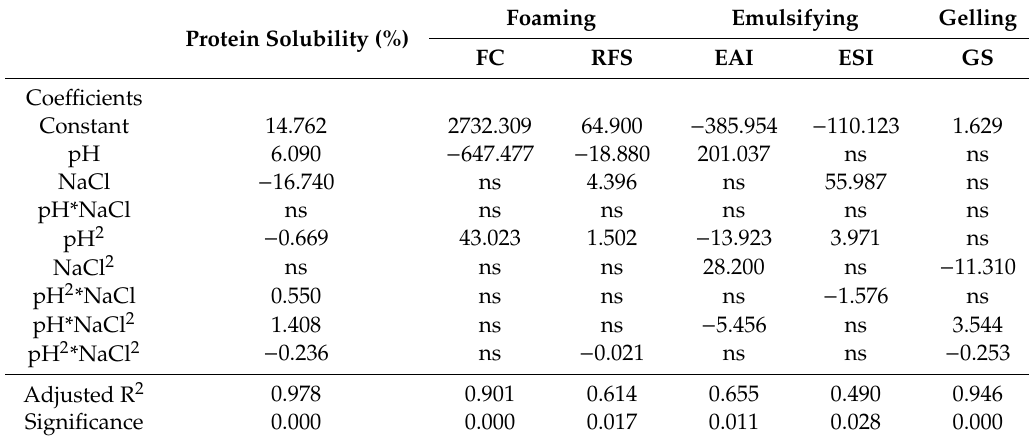
Table 5. Polynomial models for the response surface methodology (RSM) optimization of functionality of protein extracts from porcine heart as a function of pH and salt concentration of the extraction bu ff er. Foaming Emulsifying Gelling Protein Solubility (%) FC RFS EAI ESI